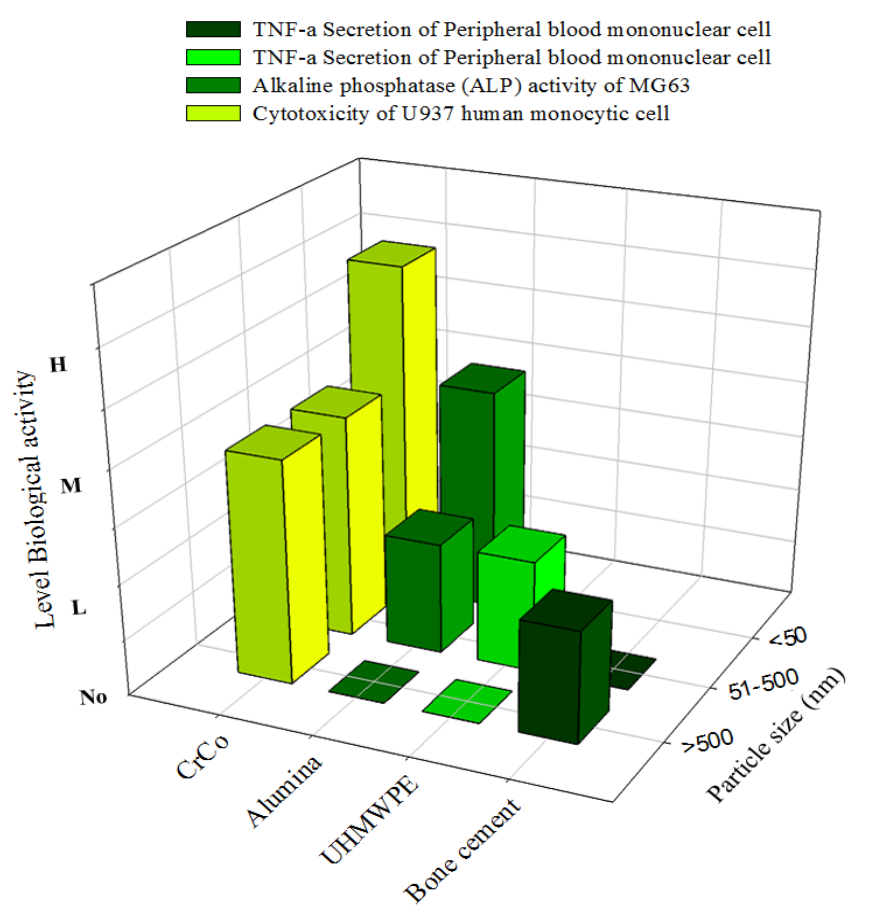
Figure 8. Size dependent biological response of wear particles (based on Table